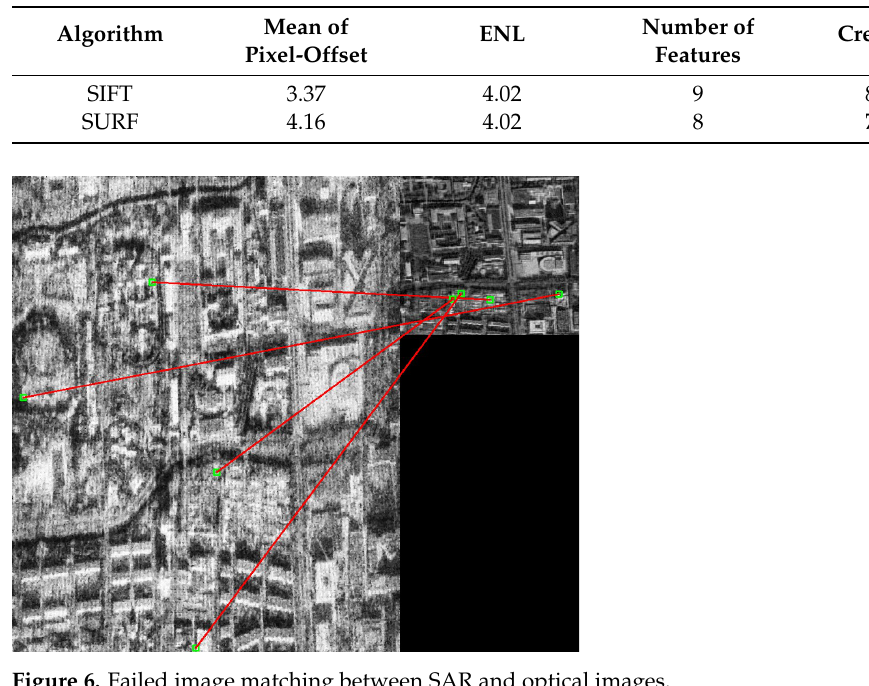
Figure 5. Image matching between SAR and optical images. Table 2. Credibility of Image Matching between SAR and optical images.